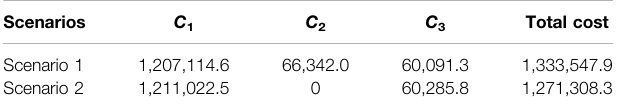
TABLE 1 | Costs of IES in Scenarios 1 and 2